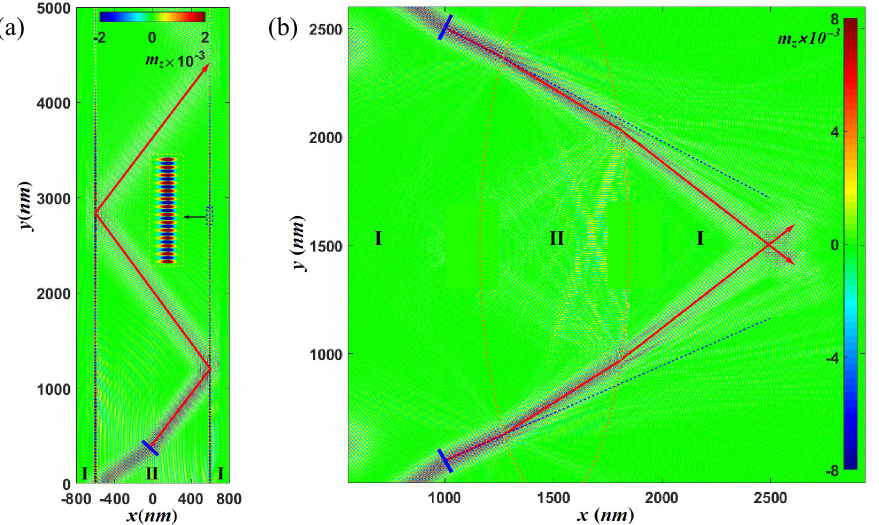
Figure 4. ( a ) Schematic illustration of a spin-wave fiber. The inset shows the enlarged figure at the interface. ( b ) Schematic illustration of a spin-wave convex lens. In all of the above figures, the color map shows z component of the magnetization in the snapshot of micromagnetic simulations at some selected time. The spin-wave trajectories are represented by solid red lines with an arrow. The simulated propagation of the spin wave excited by a AC source in blue bars with an exciting frequency f = 100